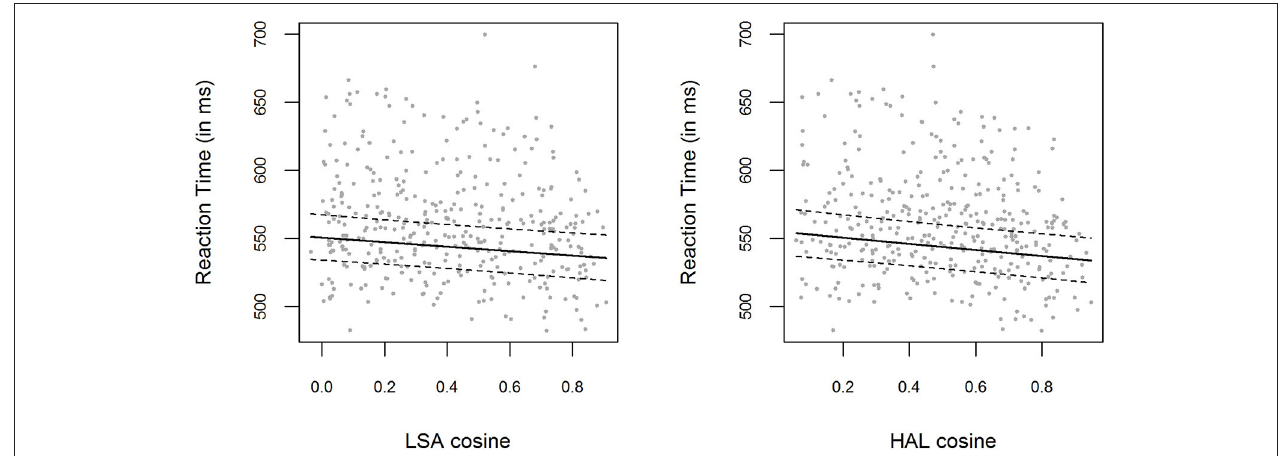
FIGURE 3 | (Left panel) Mean RTs for each item in the pooled data from Experiment 1 and Experiment 2, plotted as a function of the prime-target LSA cosine similarity. The solid line shows the exponentiated model predictions of the model including cosine fixed effects, with the corresponding 0.95 confidence interval (dashed line). (Right panel) Mean RTs and model predictions, as in the left panel, for HAL cosine similarities.